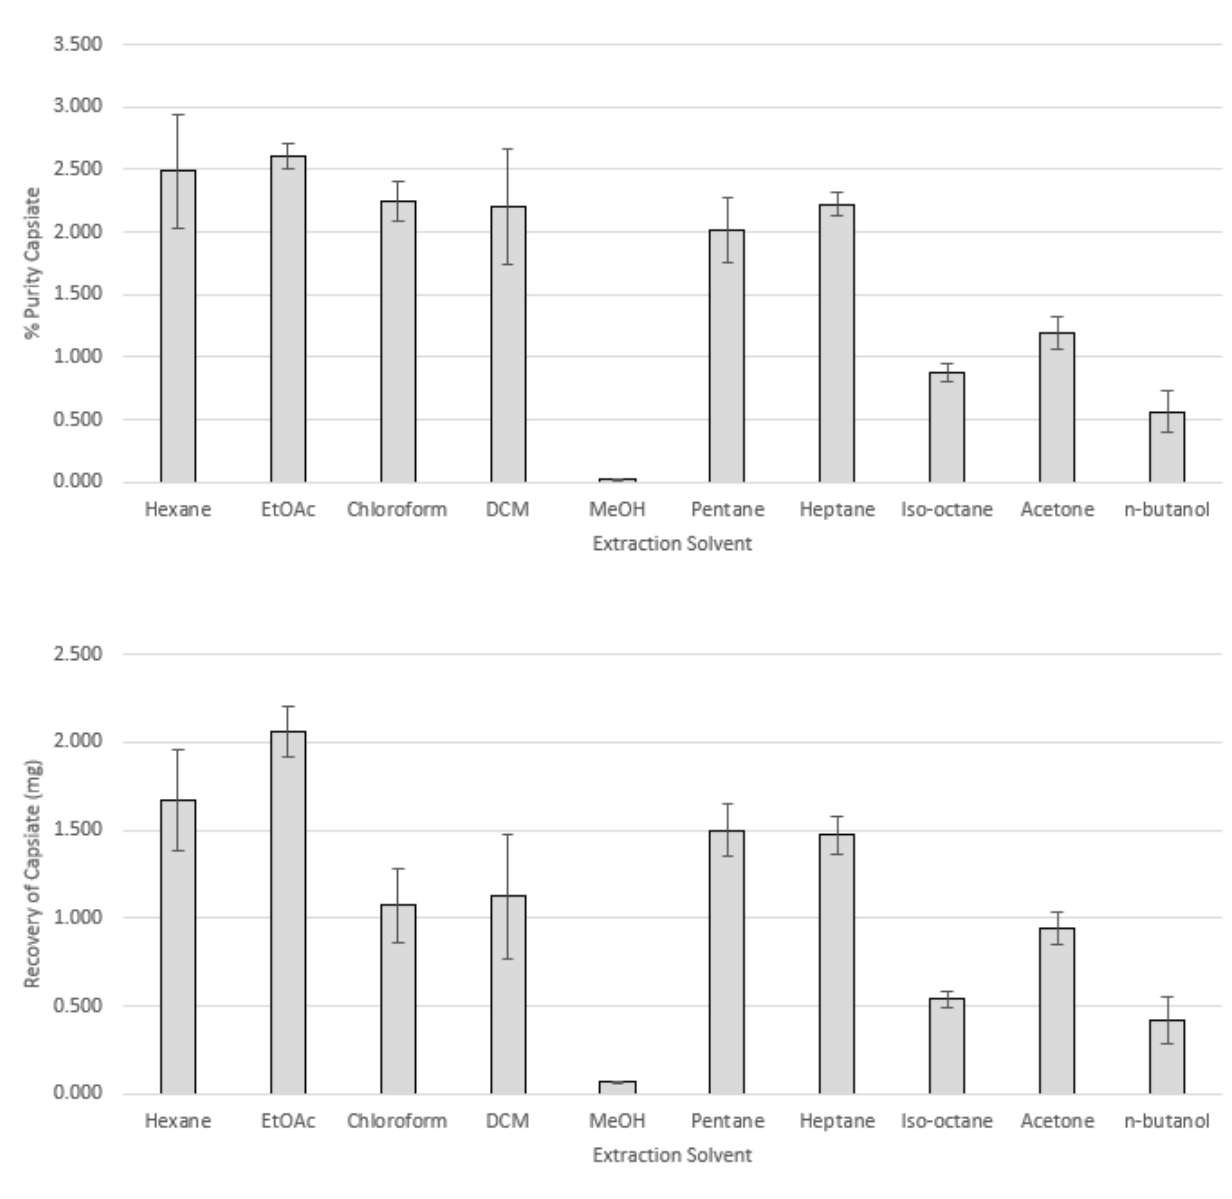
Figure 2. Extraction efficiency of solvents on the purity and recovery of capsiate from dried fruit of Capsicum annuum (509-45-1).